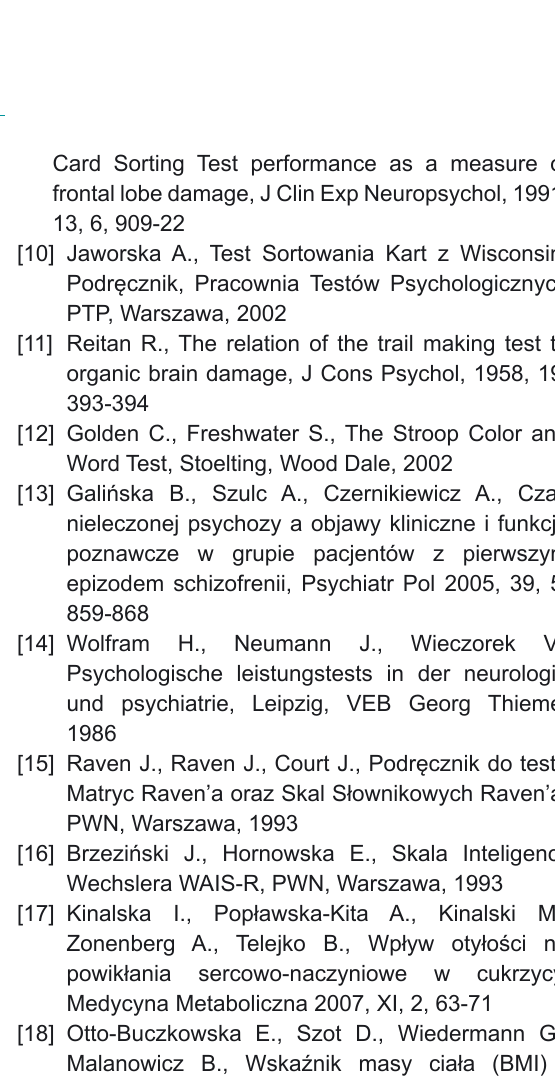
Card Sorting Test performance as a measure